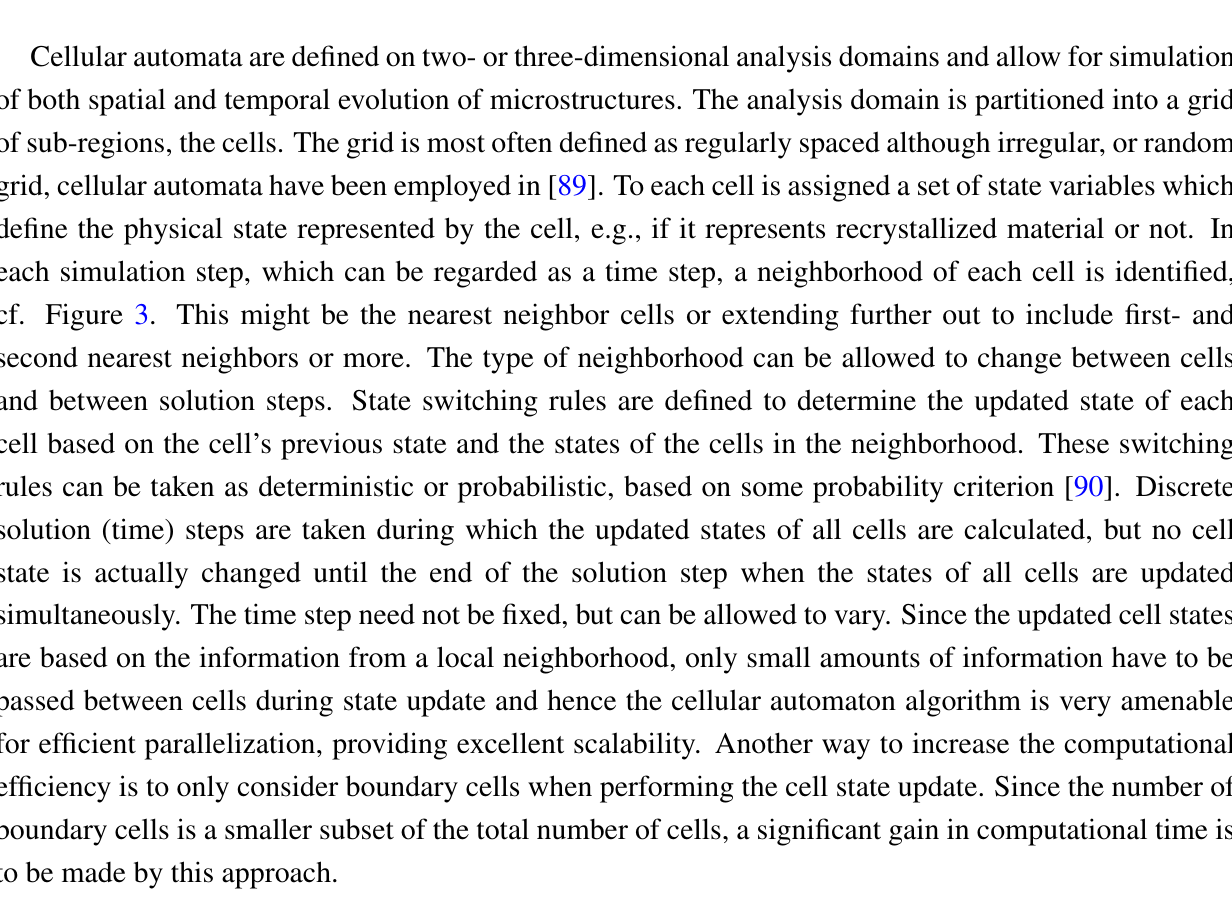
Figure 3. Illustration of a 2D cellular automaton with square cells. Two common types of neighborhood for a cell i are illustrated (shaded gray): ( a ) von Neumann neighborhood; and ( b ) Moore